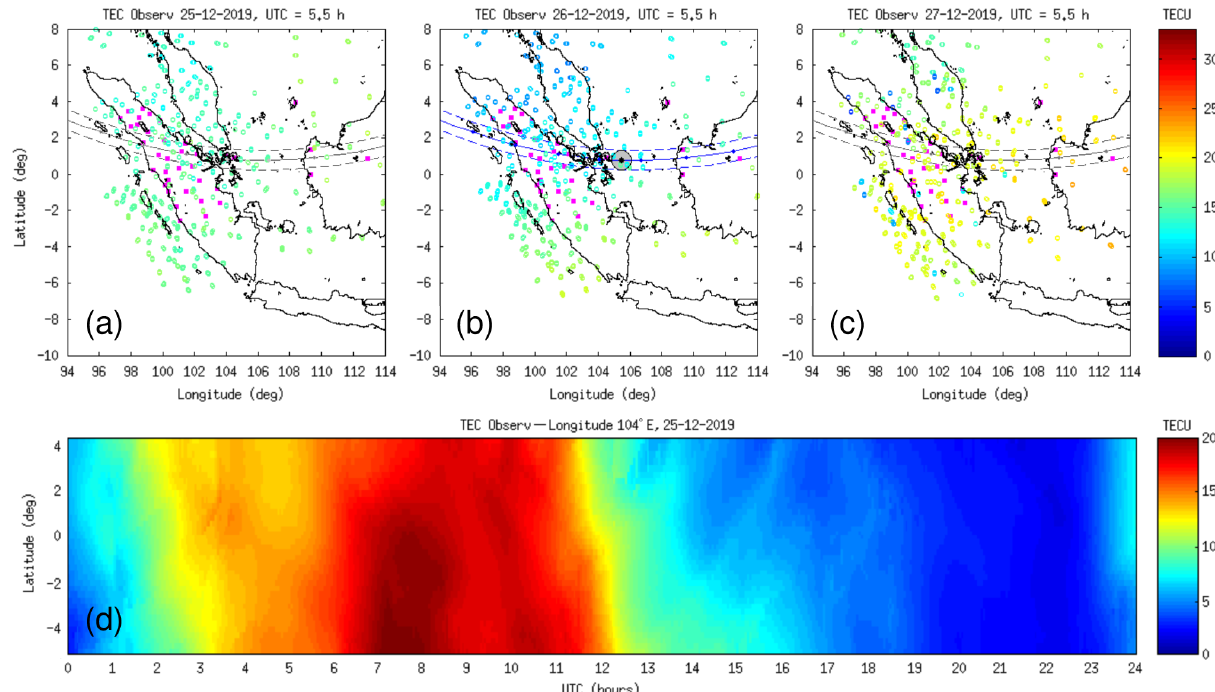
Figure 3. Geographical maps showing the spatial distribution of the GPS IPPs at 350km altitude at 05:30UTC on (a) 25, (b) 26, and (c) 27 December 2019. The path of the annular solar eclipse on 26 December 2019 is shown as a blue curve, and the location of eclipse annularity at this epoch is shown as a gray-filled circle. As a visual guide, the eclipse path is also displayed as a gray curve on 25 and 27 December 2019. Locations of ground-based GPS receiver stations are shown as magenta squares, and the TEC observation values are indicated on the individual IPPs using a color map. (d) Sample TEC keogram on 25 December